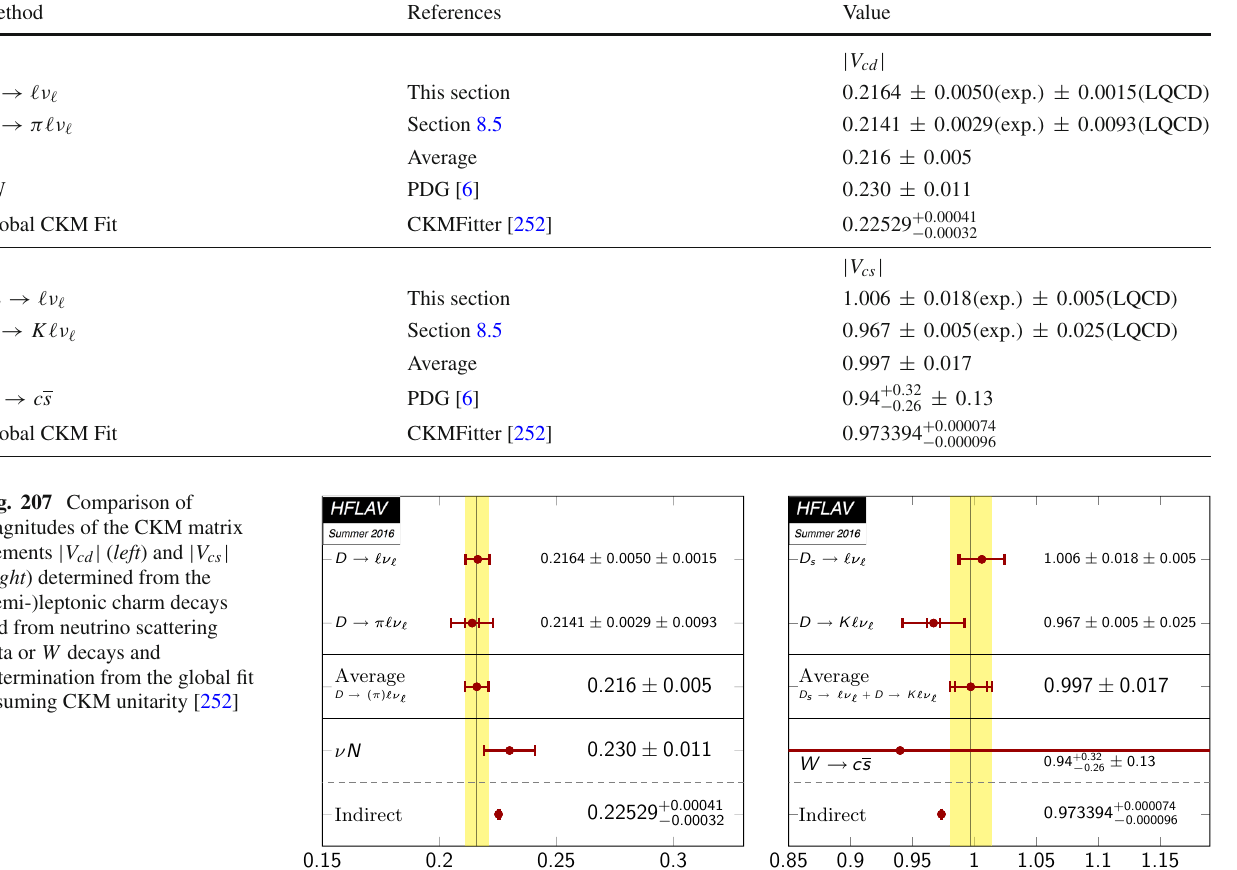
Table 284 Average of the magnitudes of the CKM matrix elements | V | and | V | determined from the leptonic and semileptonic D and cd cs D s decays. In the calculation of average values we assume 100% cor-